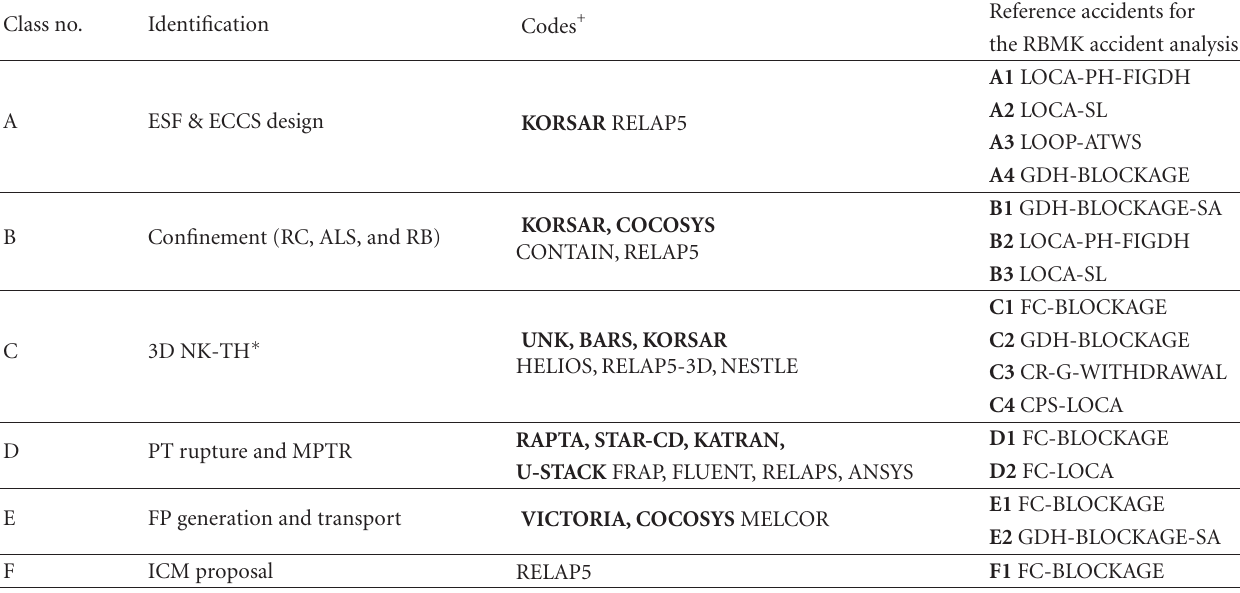
Table 1: Transient scenarios relevant to RBMK safety and design that are reference for the project and correspondence with adopted code or chain of